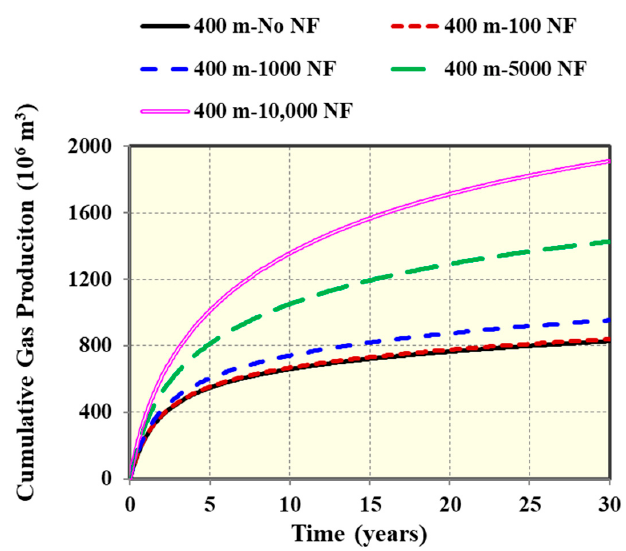
Figure 10. Effect of different numbers of natural fractures on cumulative gas production for the reservoir model with well spacing of 400 m (NF in the legend represents natural fractures).